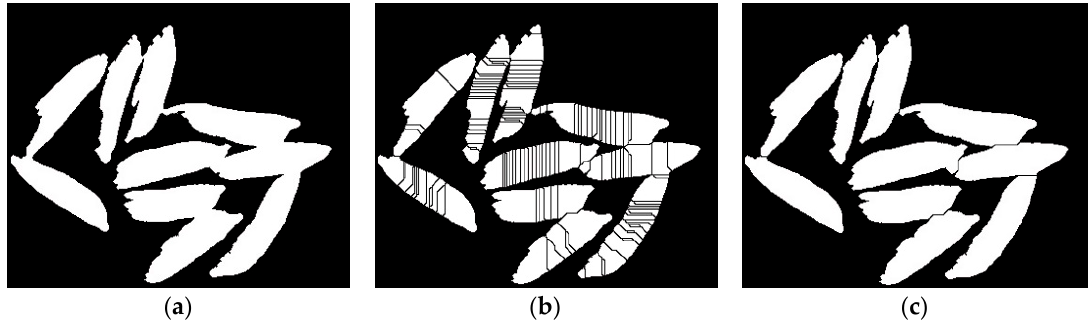
Figure 5. The result images of different watershed segmentation algorithms; ( a ) Binary image of Indica rice; ( b ) Output image of traditional watershed segmentation algorithm; ( c ) Output image of the marker-controlled watershed segmentation algorithm.